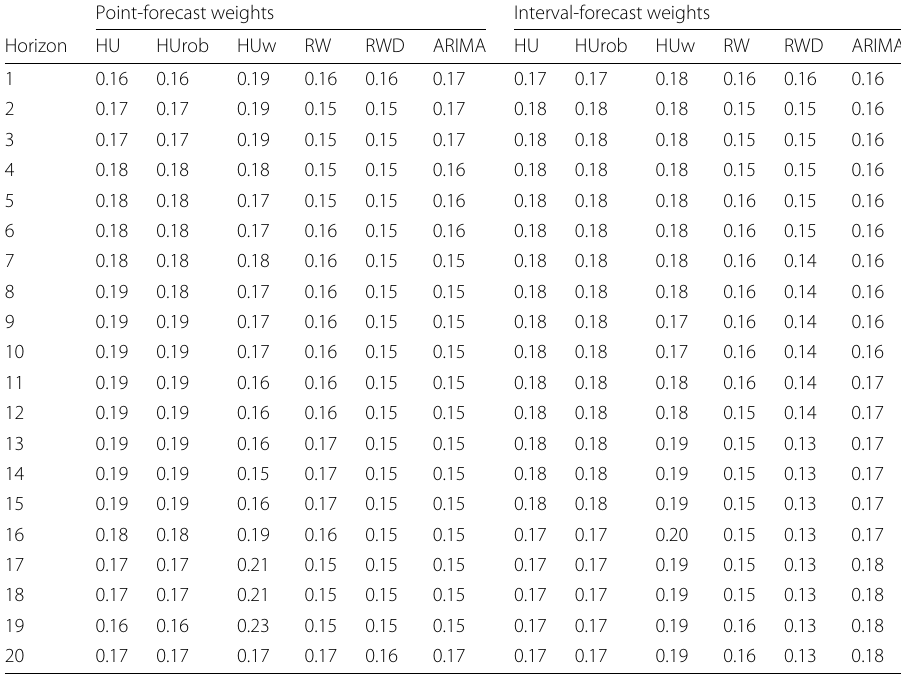
Table 4 Point-forecast and interval-forecast frequentist model-averaging weights for fertility rates in England and Wales by model and horizon Point-forecast weights Interval-forecast